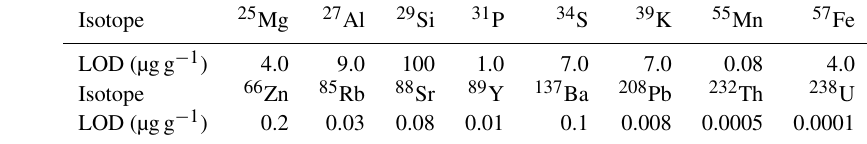
Table 2. Overview of limits of detection (LODs) of trace elements measured for this study using LA-ICP-MS.